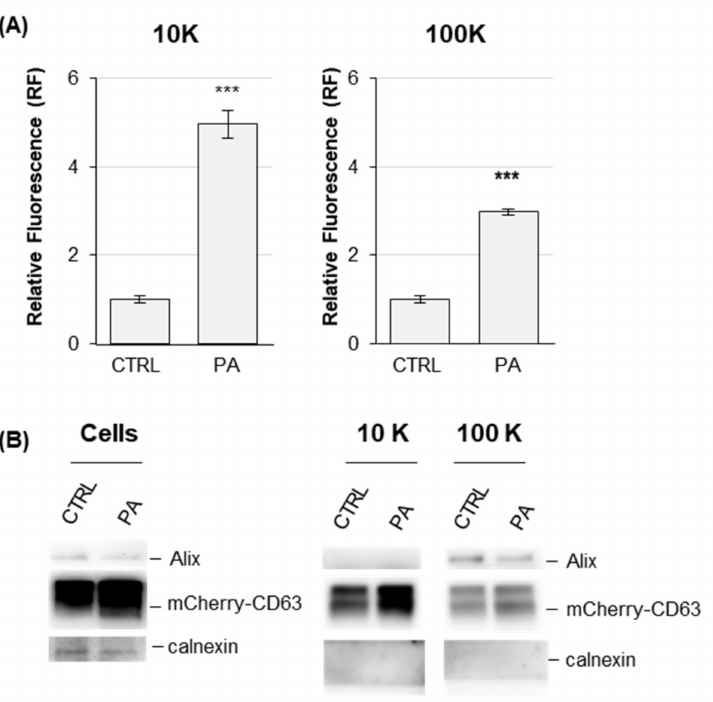
Figure 2. Analysis of EVs released by in HEK-mCherry-CD63 upon palmitic acid (PA) treatment . ( A ) Fluorescence analysis of EVs. L/mEVs (10K) and sEVs (100K) were prepared by dUC from condition media of HEK-mCherry-CD63 cells treated with 200 µ M PA. Pellets were resuspended in 100 µ L PBS and assayed for fluorescence at 580 nm ex, 620 nm em. Results represent the mean ± SE of three independent experiments performed in duplicate. *** p < 0.001 with respect to vehicle-treated cells as control. ( B ) Immunoblotting analysis of cells and EVs treated with PA. For cells, extracts were sized by SDS-PAGE and probed with an anti-mCherry antibody, stripped and probed again with anti-Alix and anticalnexin antibodies. As an internal control, the membrane was also probed with an antiactin antibody. For EVs, extracts were sized by SDS-PAGE and probed with an anti-mCherry antibody, stripped, and probed with the indicated